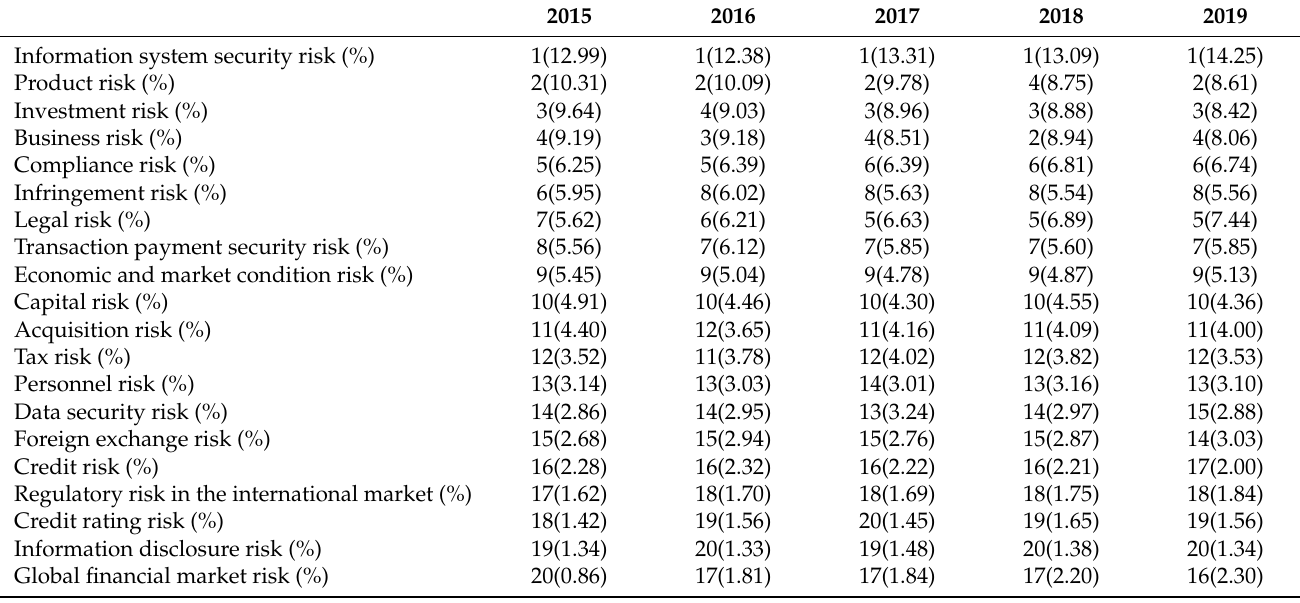
Table 3. The annual importance ranking of 20 fintech risk factors from 2015 to